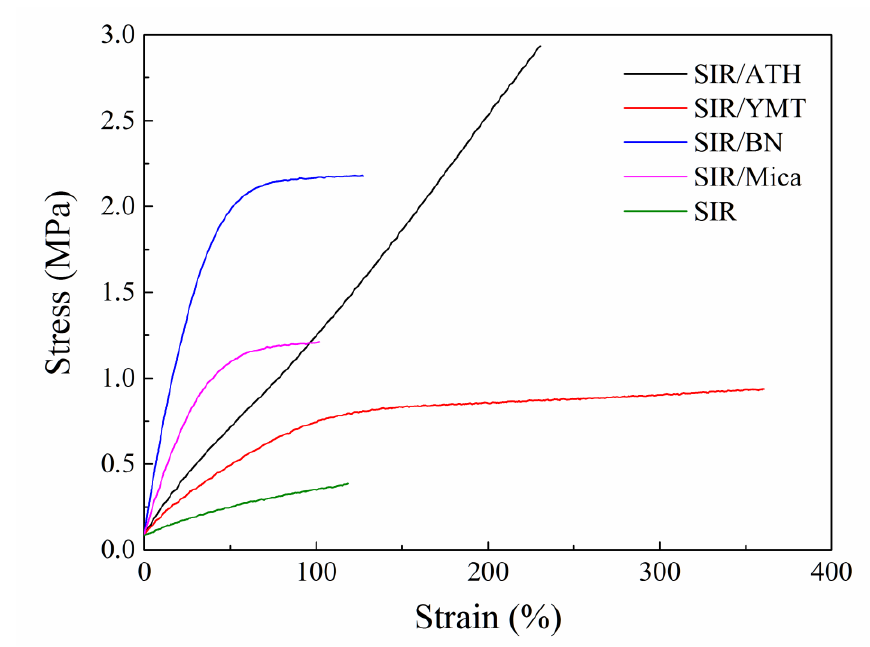
Figure 2. Stress–strain curves of SIR composites with various